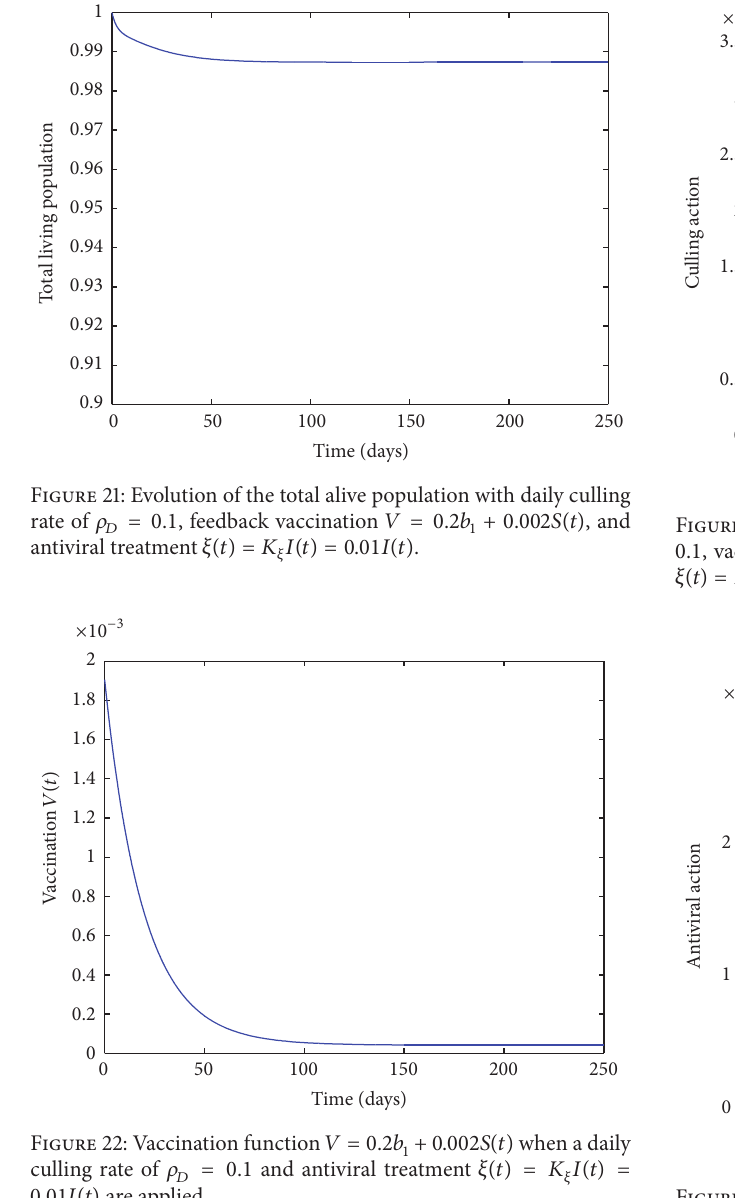
Figure 24: Antiviral action when a daily culling rate of 𝜌 𝐷 = 0.1 , vaccination law 𝑉 = 0.2𝑏 1 +0.002𝑆(𝑡) , and antiviral treatment 𝜉(𝑡) = 𝐼(𝑡) = 0.01𝐼(𝑡) are 𝐾 𝜉